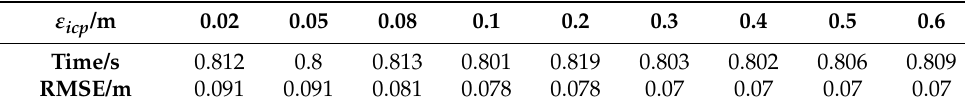
Table 3. ε = 0.3 m, the registration results of different ransac Table 3. ε ransac = 0.3 m, the registration results of different ε icp .